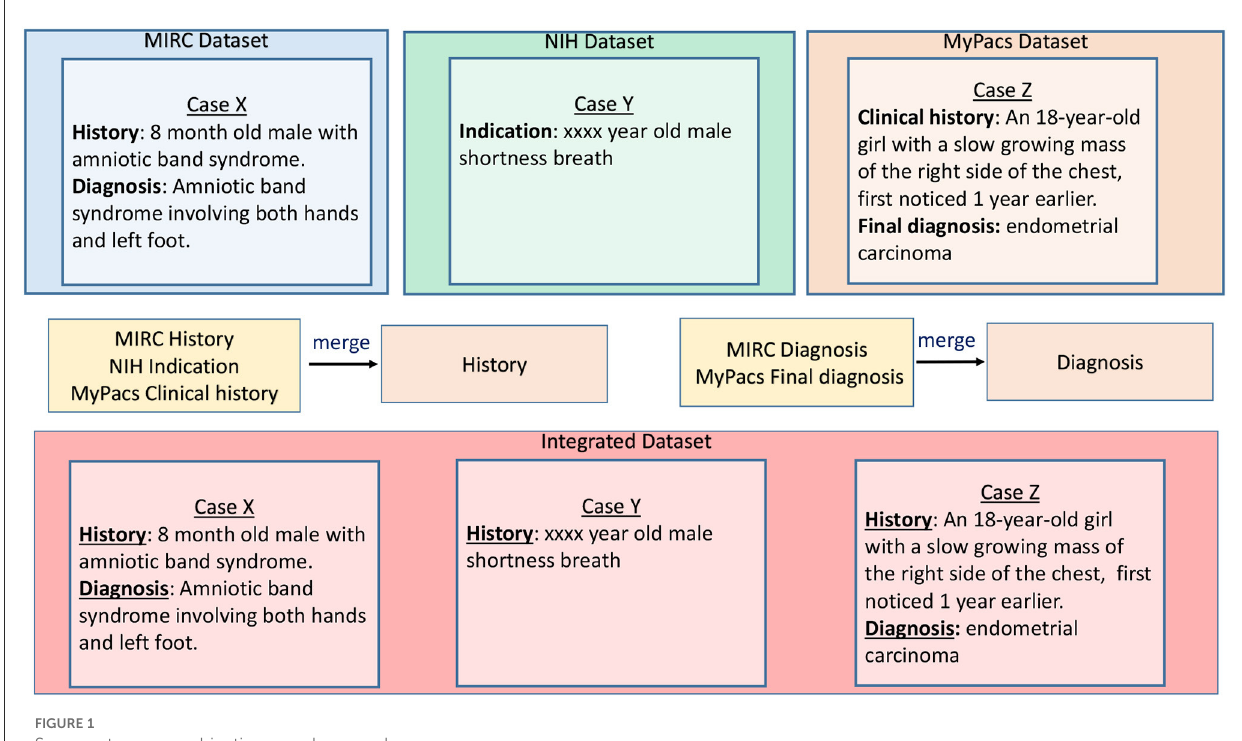
FIGURE1 Super-category combination sample